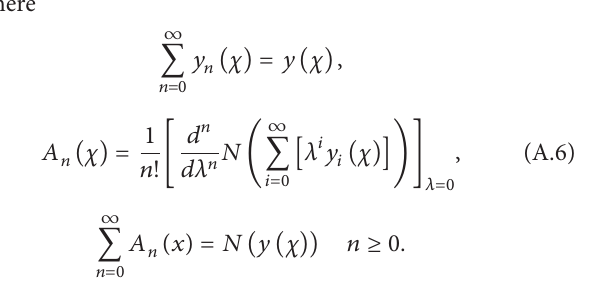
(13), and (c) reduced mediator 𝐹 S = 1 . S